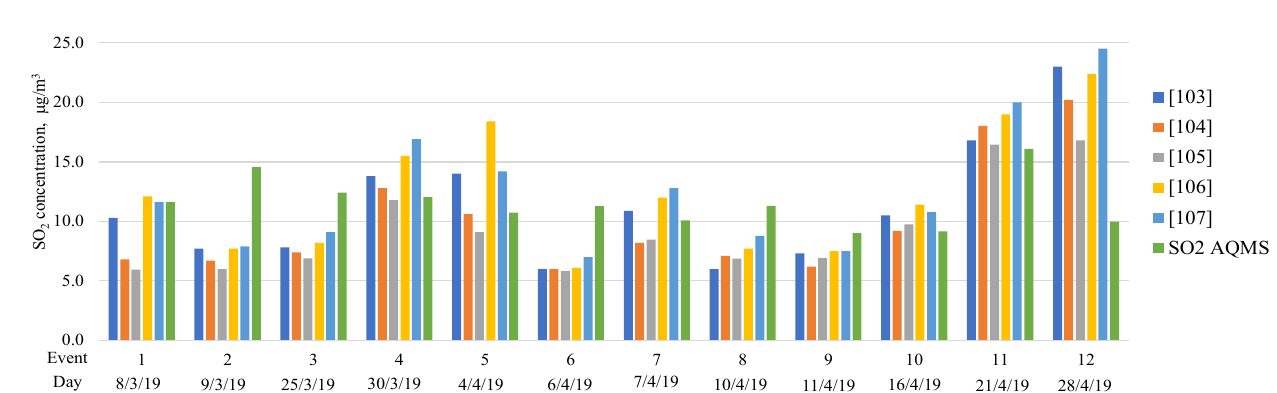
Figure 10. Distribution of SO 2 concentration ( µg/m 3 ) between the CALPUFF model and the AQMS. The SO 2 maximum concentrations from CALPUFF are shown in Figure 11. It was found that the 24 h average concentration limit established by [112,113] for SO 2 was ex- ceeded on five occasions. Using the emissions from [105], however, the reference was never exceeded. The concentration using information from [106] provided a higher concentration level than [103] due to the different specifications of the vessels. The results found for [104] were similar to [103].